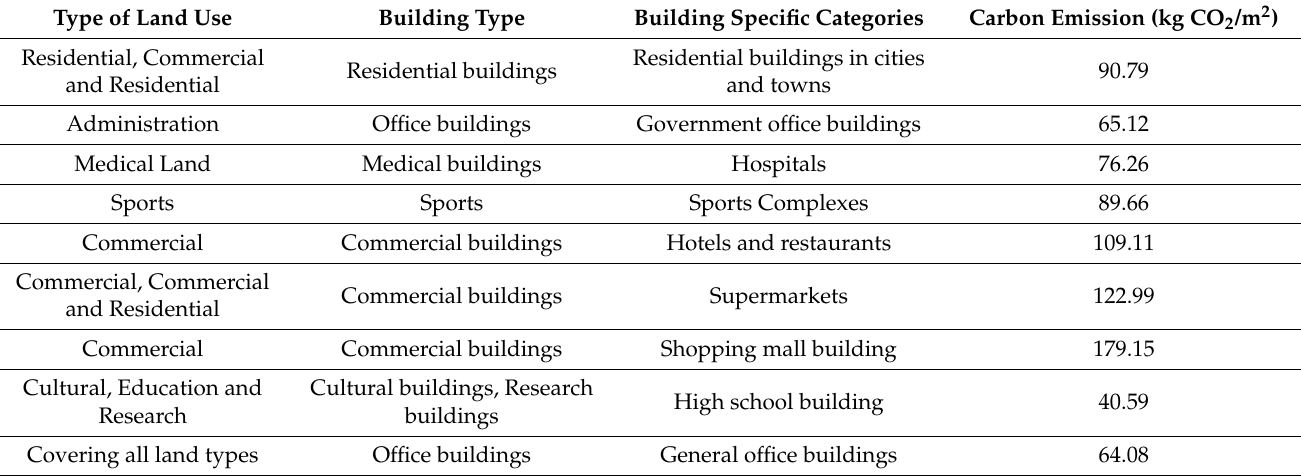
Table 4. Carbon emissions per unit of floor